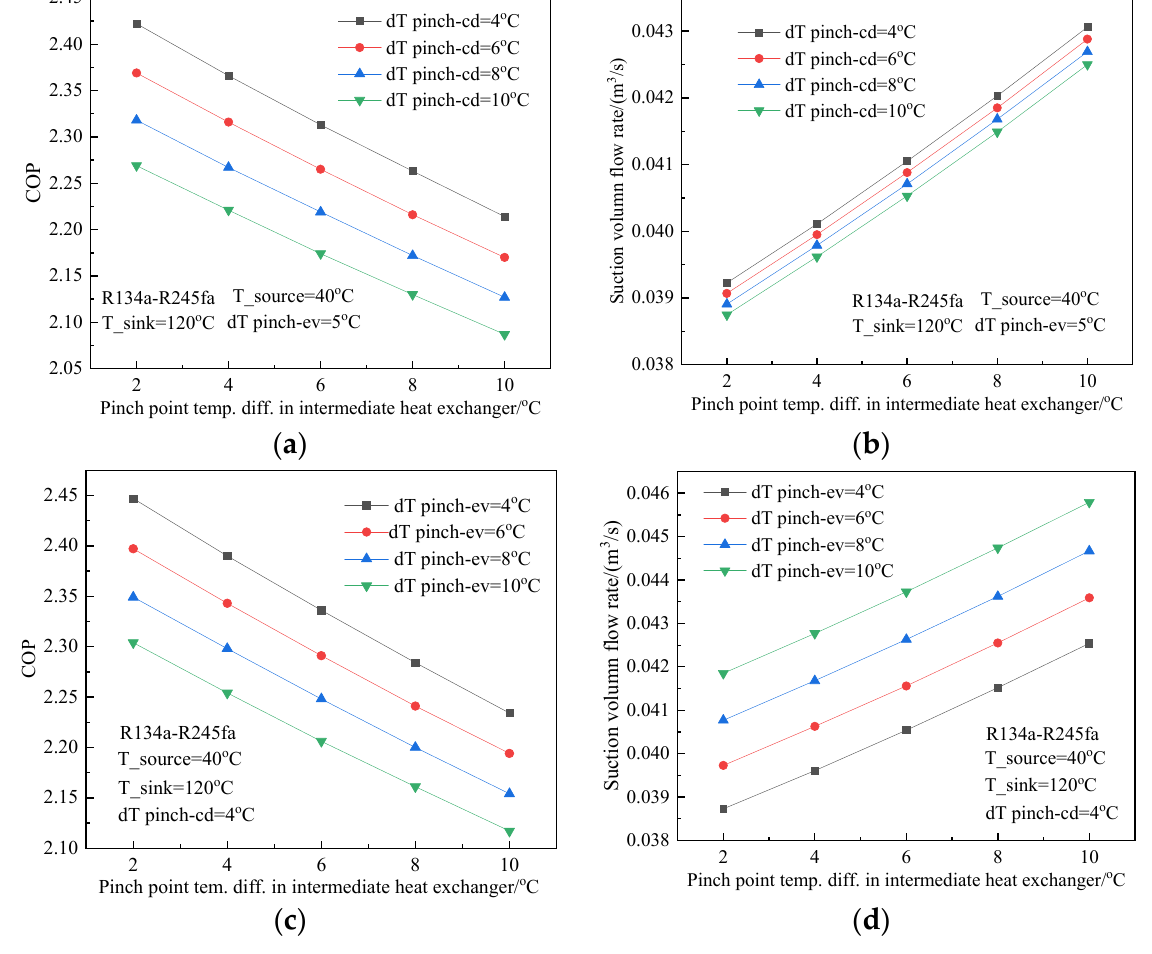
Figure 9. Effects of pinch point temperature difference on thermodynamic performance. ( a ) COP change with pinch point temperature difference at condenser and intermediate heat exchanger. ( b ) Suction volume flow rate change with pinch point temperature difference at condenser and inter- mediate heat exchanger. ( c ) COP change with pinch point temperature difference at evaporator and intermediate heat exchanger. ( d ) Suction volume flow rate change with pinch point tempera- ture difference at evaporator and intermediate heat exchanger.